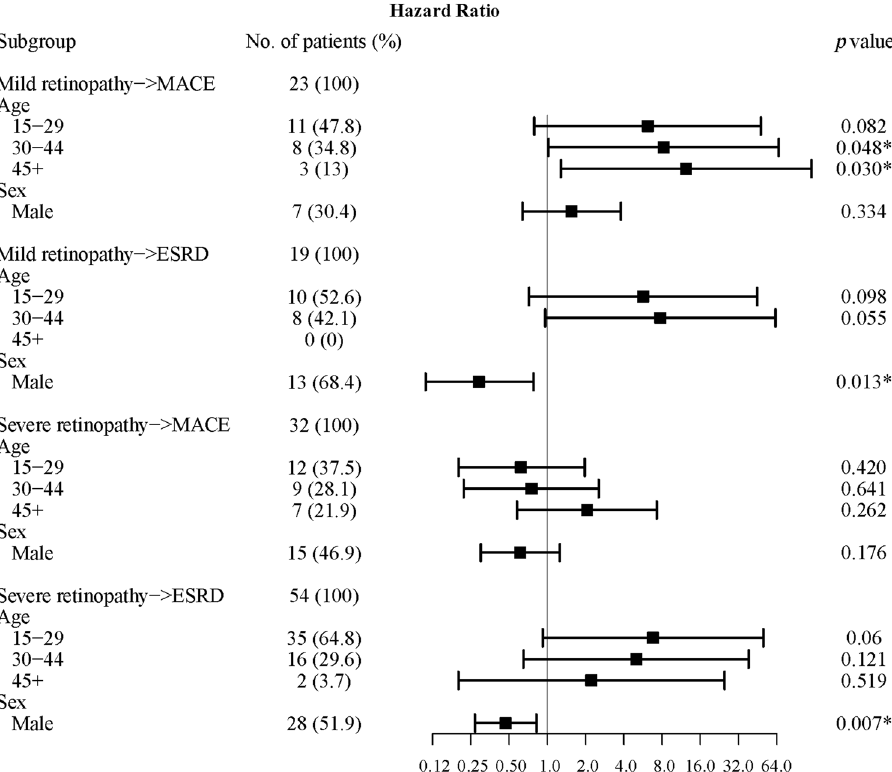
Figure 3. Forest plot of transition hazard between mild retinopathy, severe retinopathy, end-stage renal disease (ESRD), and major adverse cardiac event (MACE), stratified by age at type 1 diabetes diagnosis and sex.